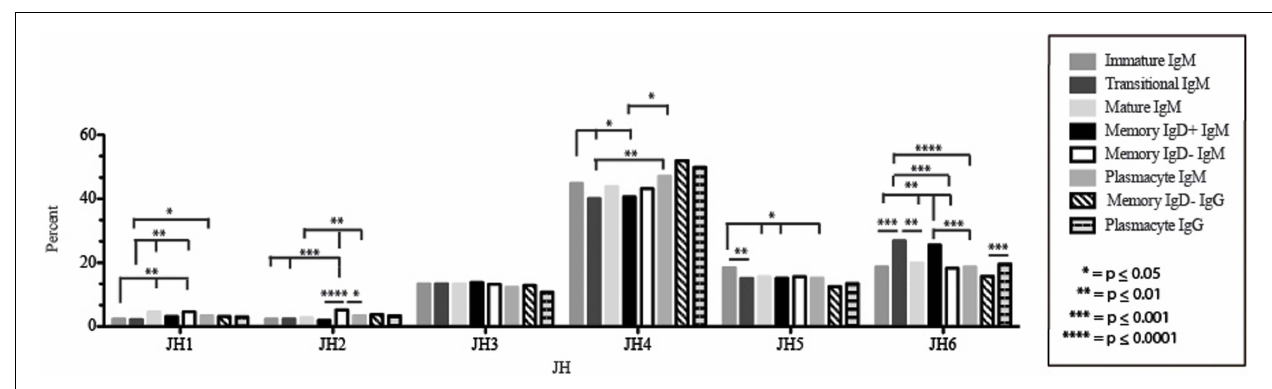
IgD − B cells, and plasmacytes are displayed. All comparisons were made using χ 2 -test or Fisher’s exact test as appropriate. Significant differences among each fraction in the different mice are indicated by asterisks: * p ≤ 0.05, ** p ≤ 0.01, *** p ≤ 0.001, **** p ≤ 0.0001.